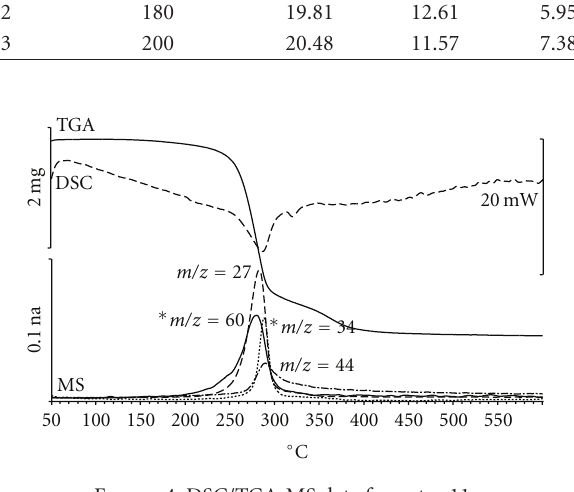
Figure 4: DSC/TGA-MS data for entry